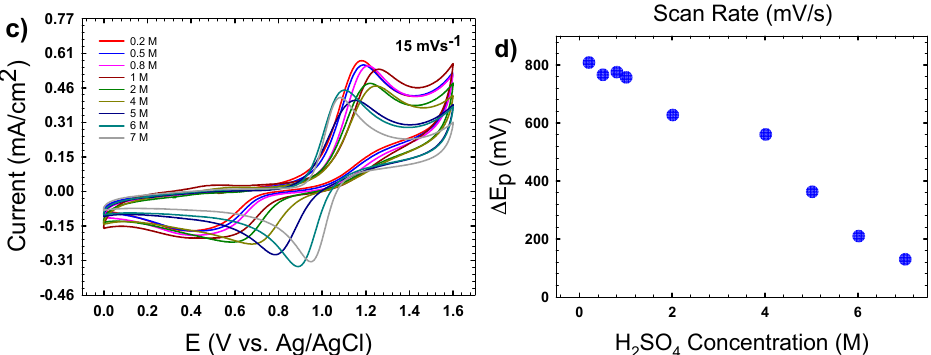
Figure 5. ( a ) Cyclic voltammograms (CVs) of 0.01 M VO 2+ in 7 M H 2 SO 4 at the indicated scan rates measured at 25 °C; ( b ) plot of peak separation ( Δ E p ) from the CVs in ( a ); ( c ) a representative set of CVs of 0.01 M VO 2+ as a function of H 2 SO 4 concentration at 25 °C, with a scan rate of 15 mV/s; ( d ) average Δ E p for CVs measured at varying H 2 SO 4 concentrations.